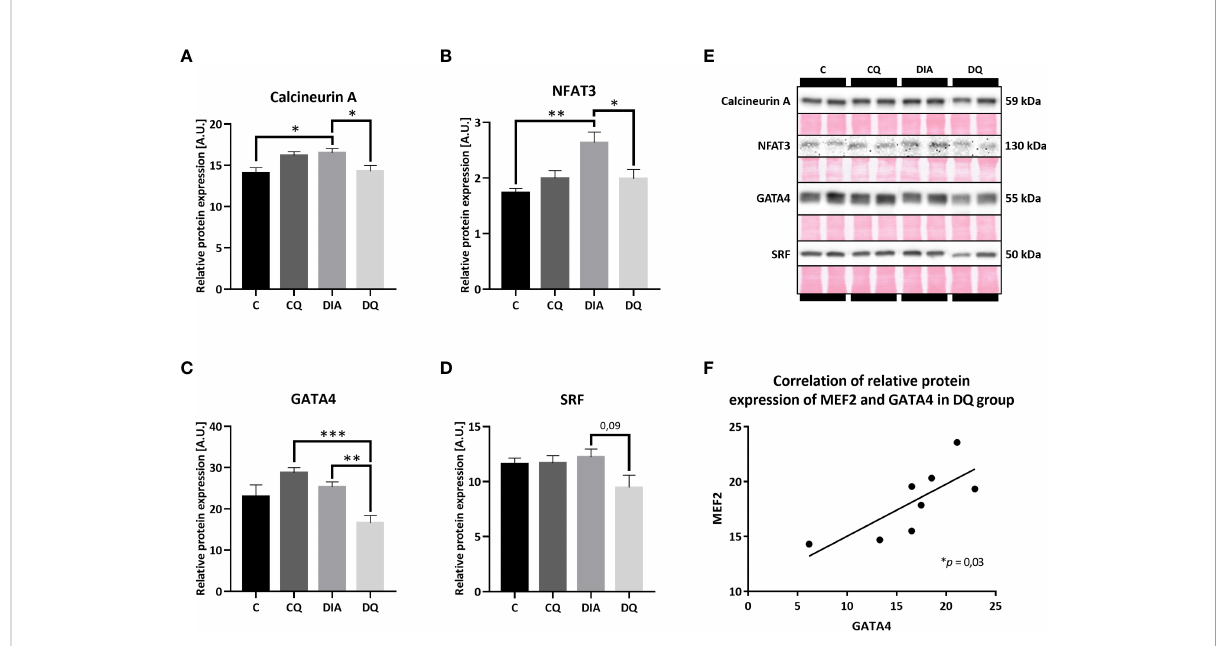
FIGURE 4 Western blot analysis of relative protein expression of (A) calcineurin A (B) nuclear factor of activated T cells 3 (NFAT3), (C) GATA4 transcription factor, (D) serum response factor (SRF). (E) Representative Western blots of detected proteins with estimated molecular weight (kDa) compared to total protein staining with Ponceau S. (F) The linear regression analysis of correlation between relative protein expression of MEF2 and GATA4 in DQ group. Data are presented as mean ± SEM and statistical differences as: * p < 0.05, **p < 0.01, *** p < 0.001 (one-way ANOVA paired with Tukey´s multiple comparisons